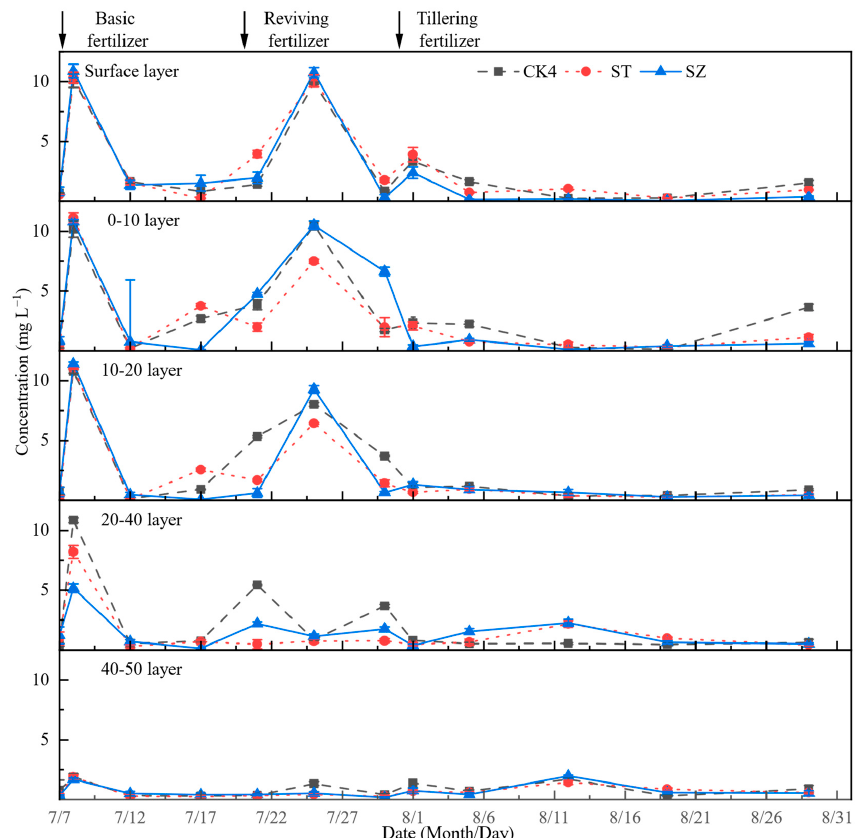
Figure 8. Dynamic changes in nitrate nitrogen (NO 3 − -N) concentration in different layers (in cm) of surface water and soil solutions under different treatments. Black squares indicate no straw returning (CK4); red circles indicate straw returning (ST); blue triangles indicate straw returning with zeolite (SZ). Different fertilizer treatments are indicated by black arrows.